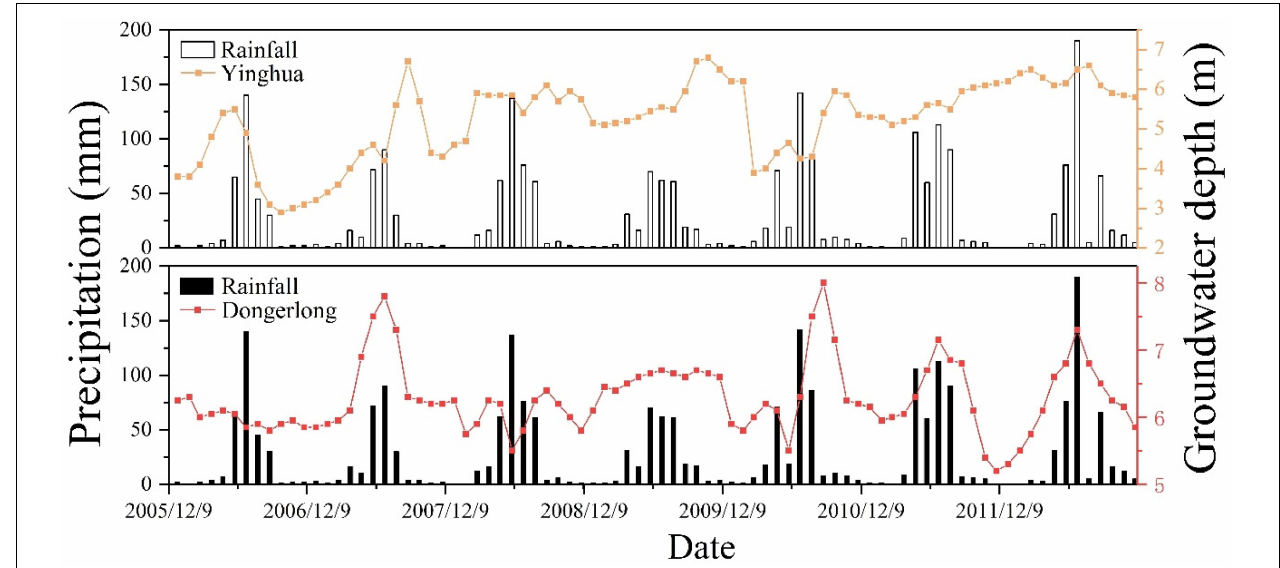
FIGURE 6 | Variations of groundwater depths in